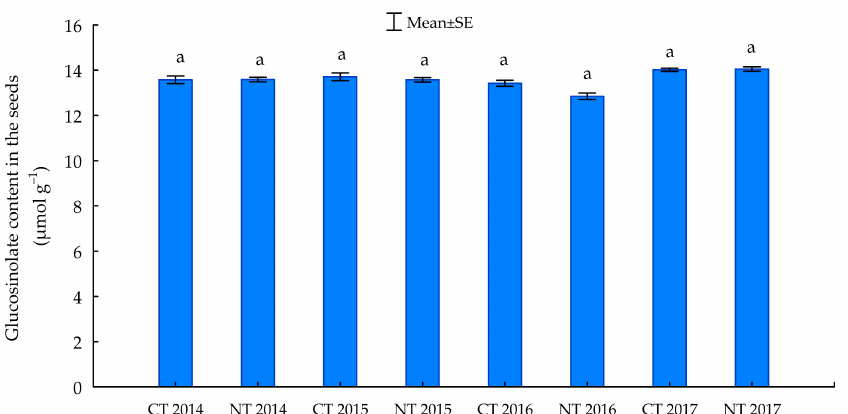
Figure 5. Interactive dependencies of tillage system and years of research in determining glucosinolate content winter oilseed rape seeds. CT—Conventional tillage; NT—No-tillage. The same letter means not significantly different values ( p ≤ 0.05).